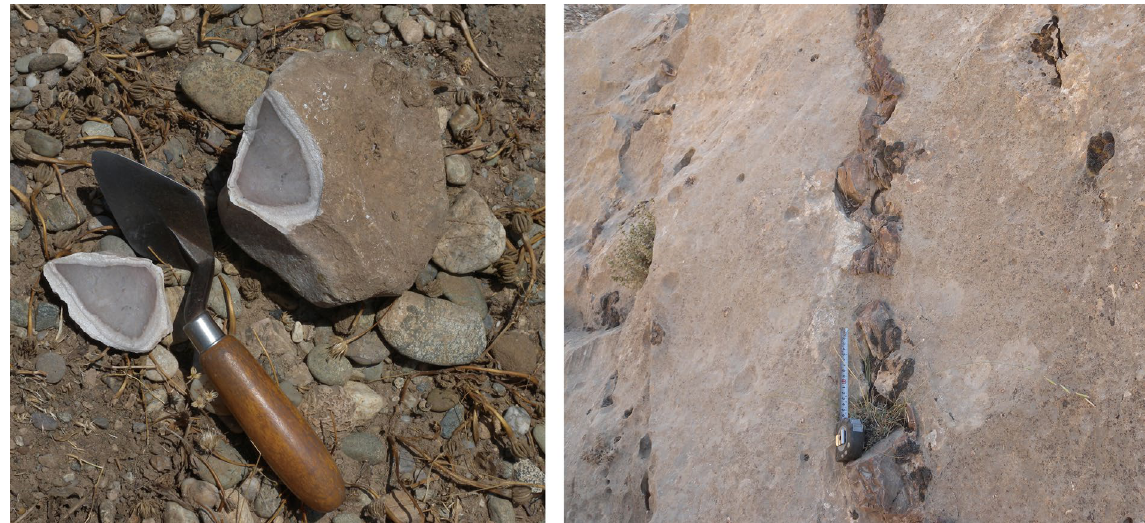
Figure 2. Local flint available near Hasankeyf Höyük. Left: River cobbles found on the river terrace of the Tigris. Right: Flint nodules embedded in a limestone bedrock at the foothill of Raman Dağ .